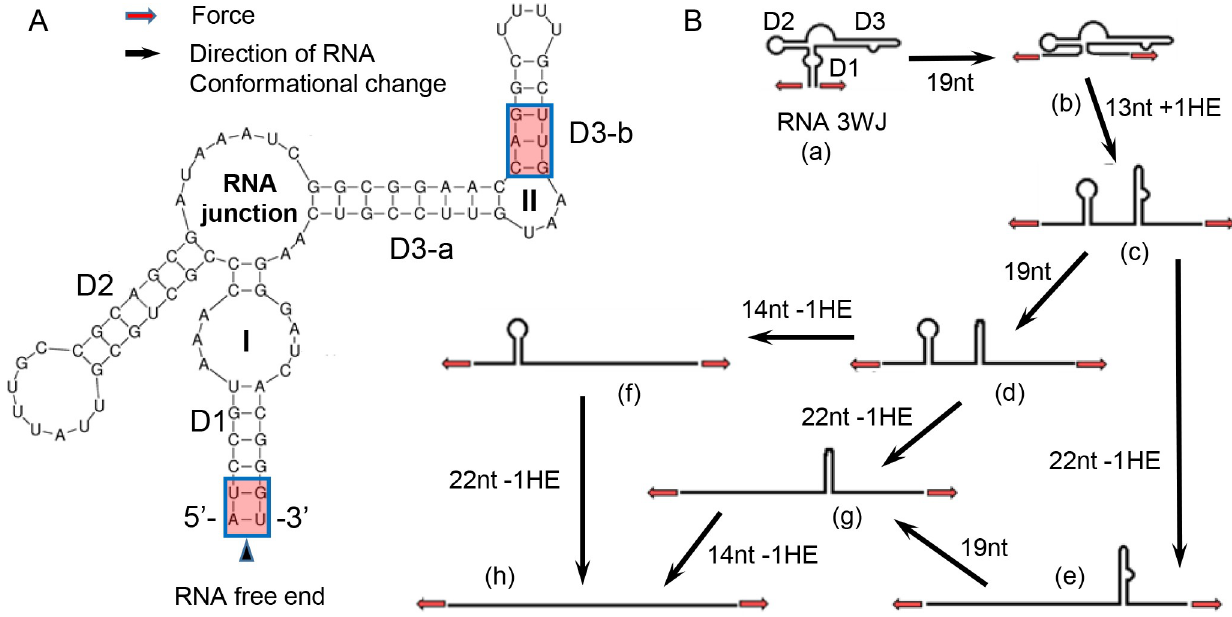
Fig 2. Secondary structures of rpoS inhibitory stem and its conformational changes under external force. (A) the secondary structures of rpoS inhibitory stem. Roman numerals I, II indicate different RNA bulges. Inside red boxes are weak internal cohesion region. (B) RNA intermediate states and potential pathway of conformational changes. The intermediate states are labelled from a to h. Numbers beside black arrows are the number of nucleotides (followed by nt) that are released during a state change in the direction of the arrow, and number of helix ends (HE) that are exposed (+) or eliminated (-) during RNA